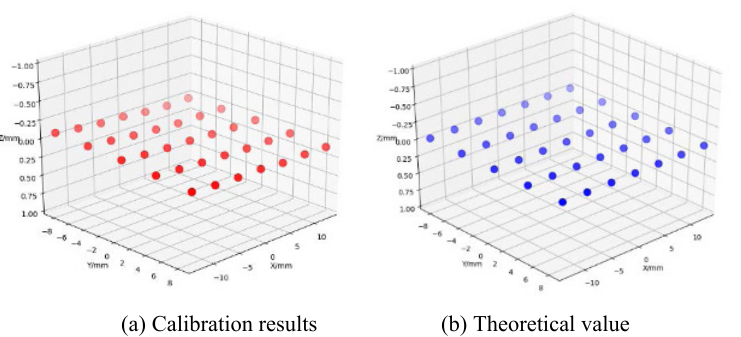
Fig. 3. Comparison between the calibration results the theoretical values.